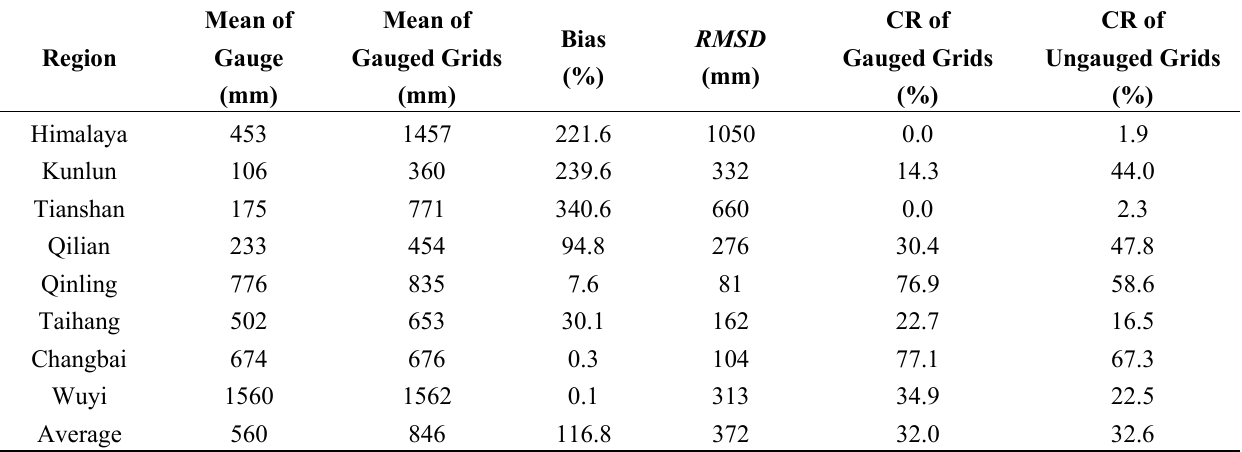
Table 7. Comparison of mean annual rainfall (2001–2012) from gauge measurements and original